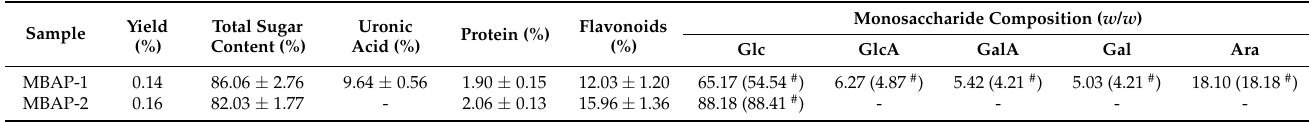
Table 2. The primary chemical characteristics of MBAP-1 and MBAP-2.